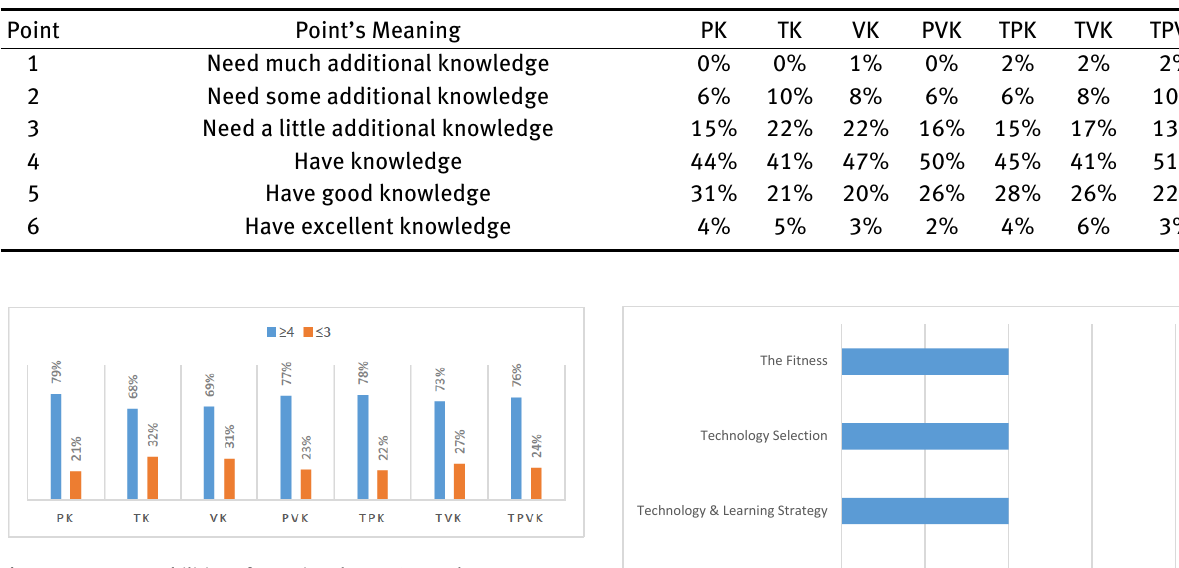
Figure 2: TPVK capabilities of vocational non-ICT teachers